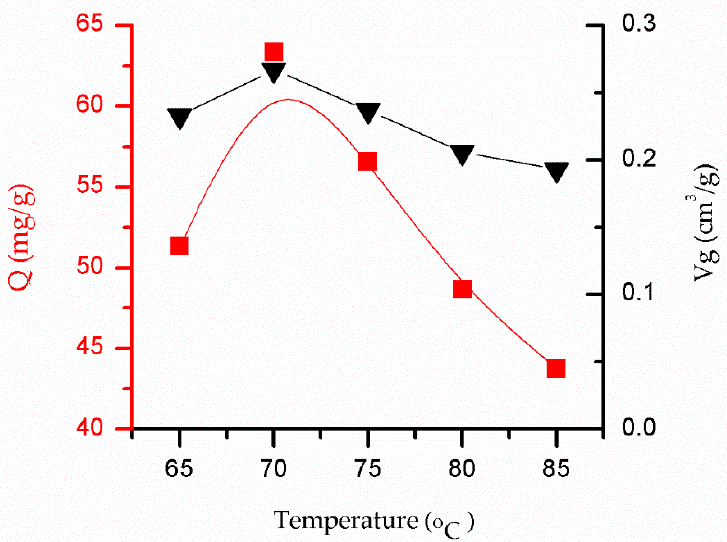
Figure9. Figure 9. The influence of the temperature on the adsorption performance of SSO-MIPs and pore volume.